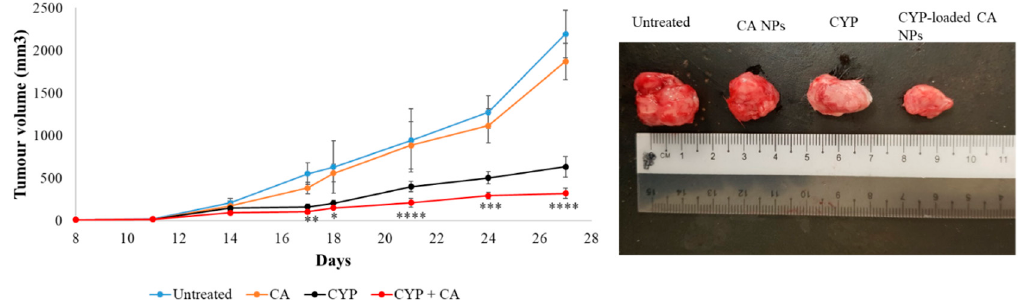
Figure 3. Treatment e ff ects of free CYP, CYP-loaded CA NPs, and drug-free CA NPs compared to the untreated group of mice. Tumor picture was taken at day 27 after the mice were sacrificed humanely via euthanasia. Values were significant (*) at a p -value of 0.01 to 0.05, very significant (**) at a p -value of 0.001 to 0.01, highly significant (***) at a p -value of 0.0001 to 0.001, and extremely significant (****) at a p -value < 0.0001 vs. the same treatment with free CYP at a confidence interval (CI) of 95%.